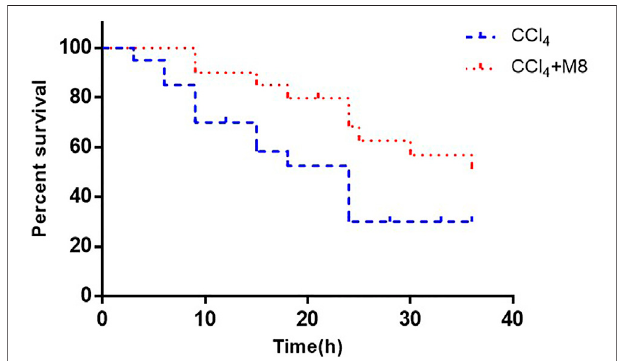
FIGURE 8 | The effect of midazolam pretreatment on the survival rate of mice in which liver injury was induced by CCl 4 . Midazolam was i. p. injected at 8 mg/kgfor3 days50%CCl 4 (2.6 ml/kg)werei.p.injectedat2 hafterthelast doseofmidazolam( n =20).Theresultswereanalyzedusingthelog-rank test and expressed as Kaplan-Meier survival curves.